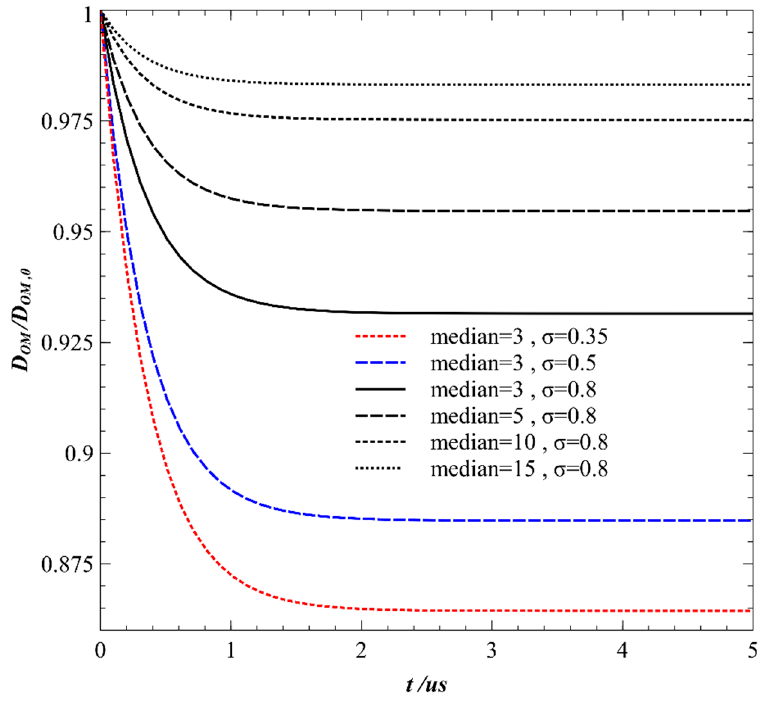
Figure 10. The variation of the GDC with the different pore size distribution.